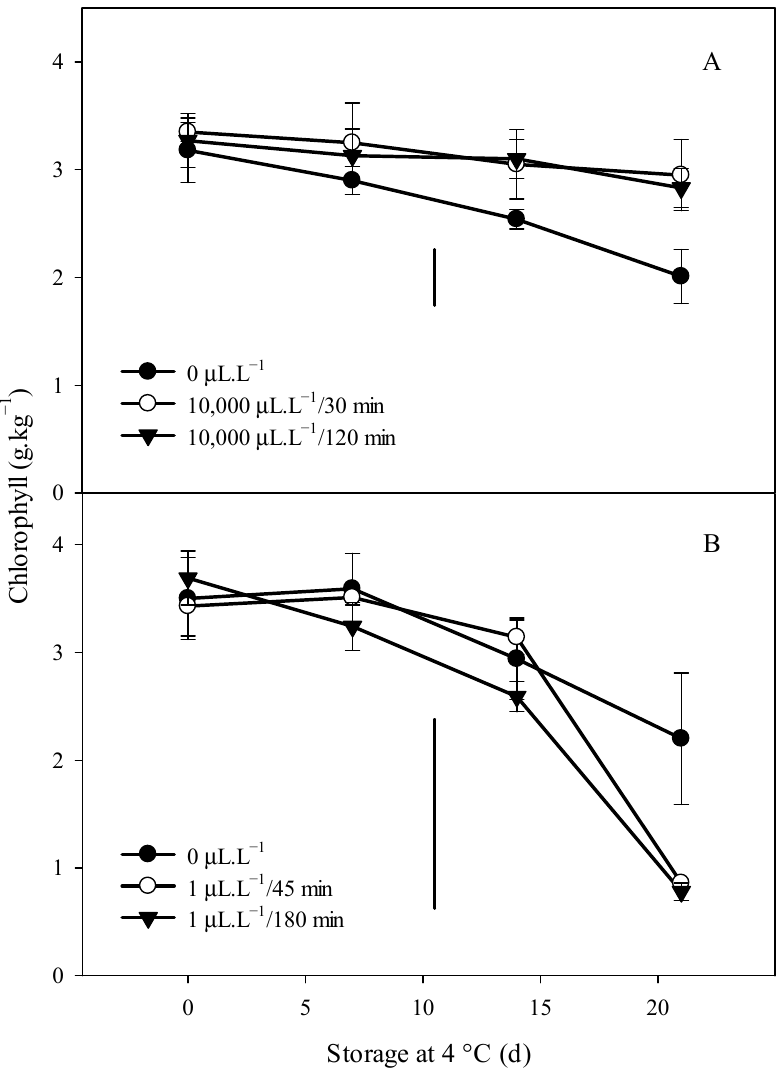
Figure 4. Evolution of chlorophyll content of broccoli florets exposed to ethanol and methyl jasmonate. Broccoli florets were treated with ethanol ( A ) at three di ff erent doses: ( ● ), control; ( ○ ), 10,000 µL.L − 1 /30 min (hormetic dose); and ( ▼ ), 10,000 µL.L − 1 /120 min (high dose). Methyl jasmonate ( B ) ( ● ), control; ( ○ ), 1 µL.L − 1 /45 min (hormetic dose); and ( ▼ ), 1 µL.L − 1 /180 min (high dose). Color change ( Δ E) was observed during 21 d of storage in darkness at 4 °C. Color change ( Δ E) was observed for 21 days of storage in darkness at 4 °C. Vertical bars represent the standard deviation (n = 4). LSD (0.05), EtOH = 0.52; LSD (0.05), MeJA = 1.76.